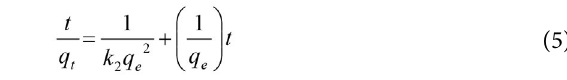
Table 3. Kinetic models parameters for MB dye adsorption at 150, 175 and 200 mg/L dye concentrations. C 0 qe exp Pseudo-first-order Pseudo-second-order Intraparticle diffusion (mg/L) (mg/g) kinetic kinetic